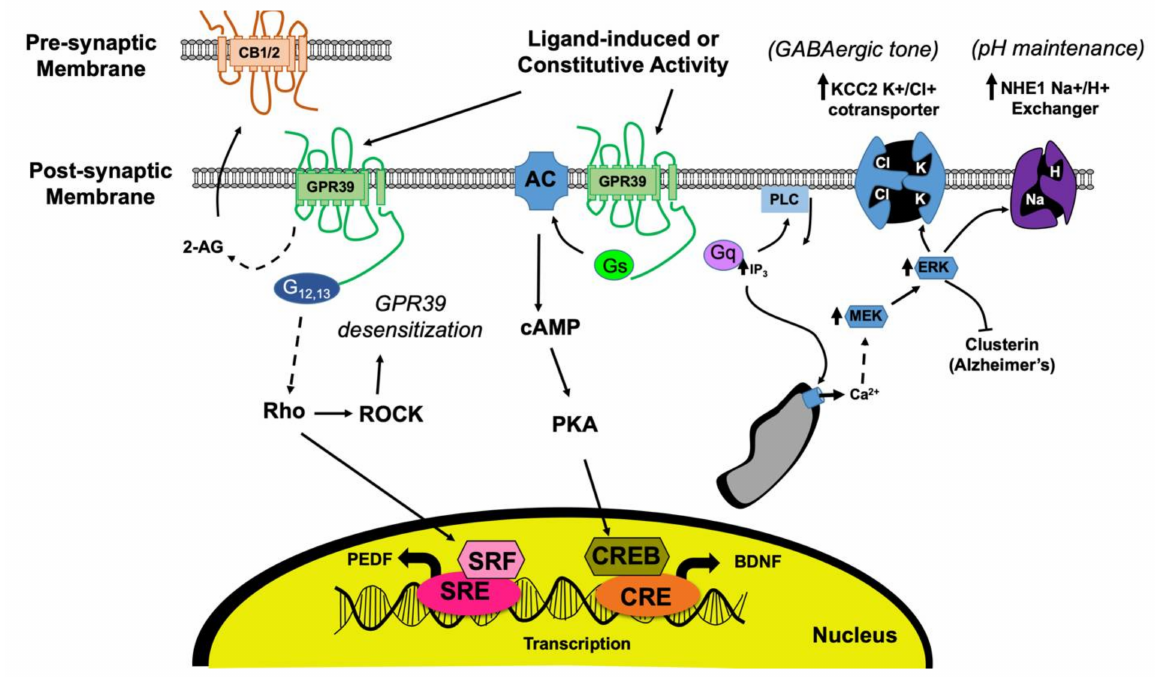
Figure 2. GPR39 signaling cascade in neural pathology. GPR39 activation by ligands activate the G α q and G α s pathways. G α q activation results in PIP2 cleaving to release membrane-bound DAG and cytosolic IP3, resulting in calcium release from ER to increase KCC2 and promote GABAergic tone, increase NHE1 activity to maintain pH, and increase 2-AG synthesis to increase presynaptic CB1R activity. ERK1/2 activation from this signaling pathway has been shown to inhibit clusterin, a protein associated with Alzheimer’s disease. G α s signaling increases cAMP levels and CRE-dependent transcription, including BDNF and TrkB, which are associated with improved memory and decreased depression. This pathway is inhibited through PKA by PKIB from the constitutive pathway of GPR39, which is coordinated through G α 12/13 and Rho kinases for SRE-dependent transcription, promoting anti-oxidative and anti-inflammatory activity. The constitutive pathway also has negative feedback for GPR39 expression through ROCK, resulting in desensitization and internalization of the receptor to prevent